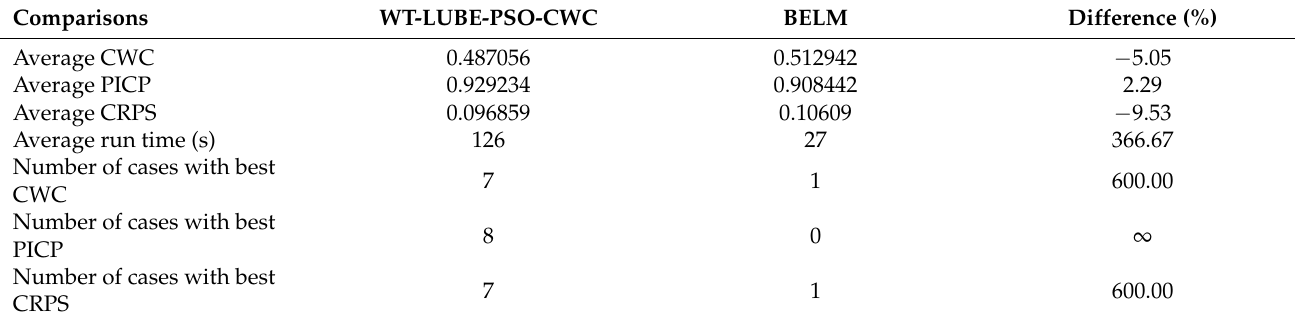
Table 13. Overall comparison of WT-LUBE-PSO-CWC and BELM models for every case of each zone.